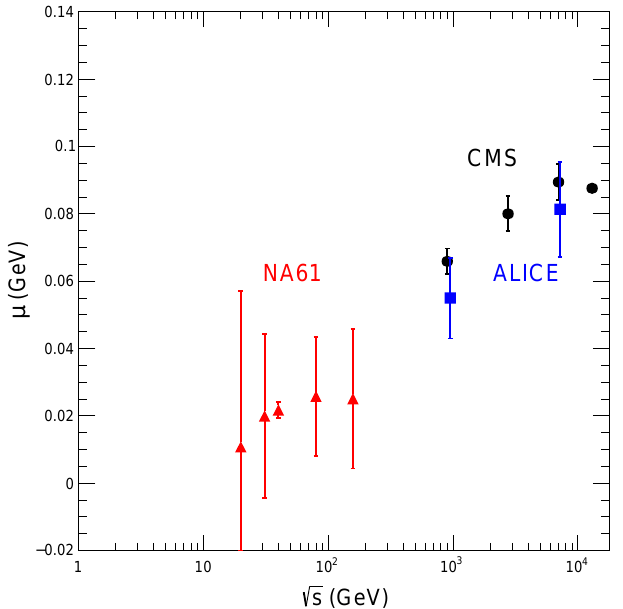
Figure 6. The energy dependence of the freeze-out chemical potential µ for pions in pp collisions. The round (red) points are obtained from fits to the results of the NA61/SHINE Collaboration [14] (see Table 5), the square (blue) points are for the ALICE Collaboration data (see Table 2), while the round (black) points are for the CMS Collaboration data (see Table